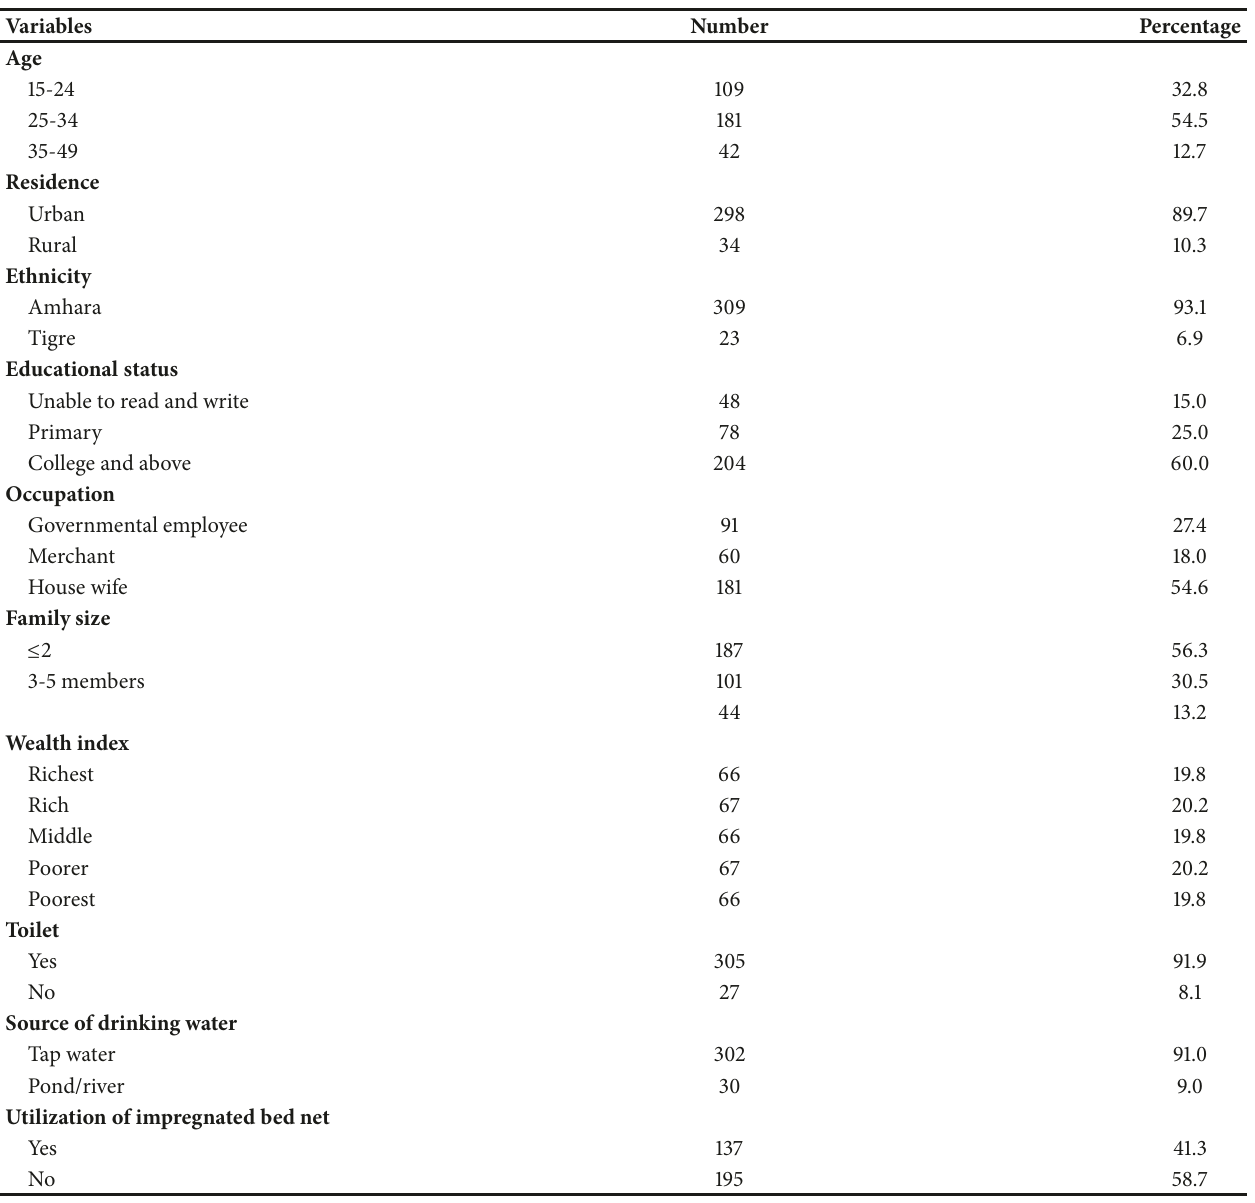
Table 1: Sociodemographic characteristics of pregnant women attending ANC at the University of Gondar Referral Hospital (n = 332).